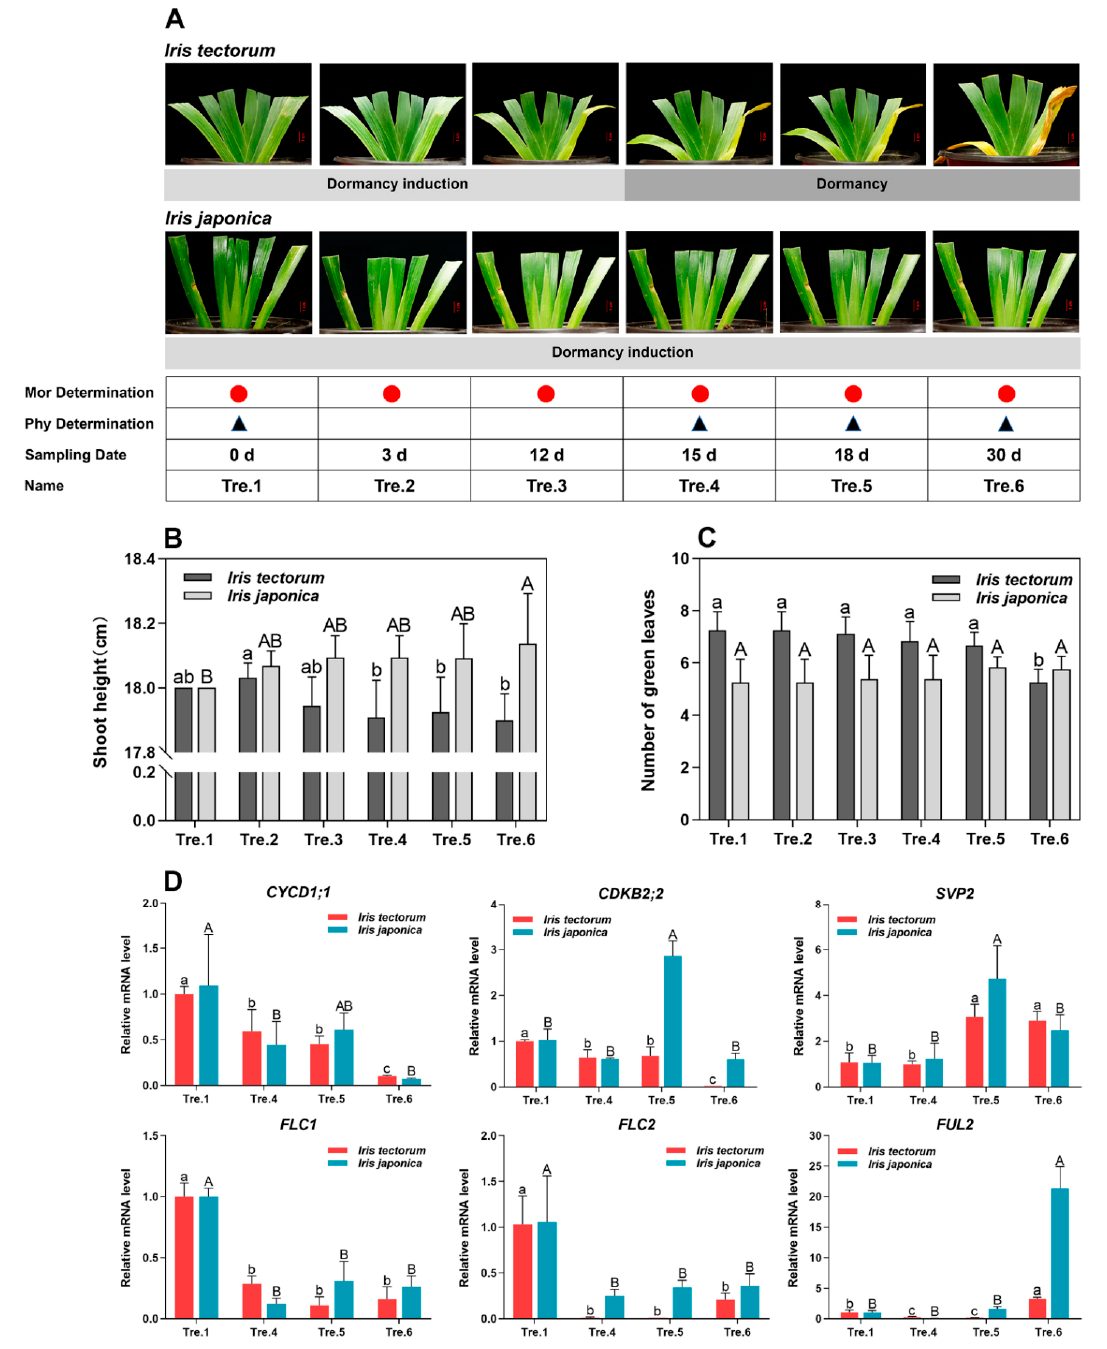
Figure 1. Sample harvesting, morphological observations, and the expression changes of marker genes in this study. ( A ) Plant status of Iris tectorum (IT) and I. japonica (IJ) at the stages for morphological observations, sampling dates for morphological (Mor) observations and physiological (Phy) measurements, and the corresponding dormancy status as defined in this study. Red circles represent plants sampled for morphological observations, and black triangles represent plants sampled for physiological measurements. ( B , C ) Morphological observations of the two iris species. ( B ) Shoot height (cm). ( C ) The number of green leaves. ( D ) Relative mRNA levels of marker genes in both iris species. Gene full names are shown in Supplemental Table S1. The data in ( B , C ) are means from nine biological replicates and the data in ( D ) are means from three biological replicates, with error bars representing standard deviation. The lowercase and uppercase letters denote significant differences for relevant parameters within IT and IJ (Duncan’s multiple comparison test p < 0.05),